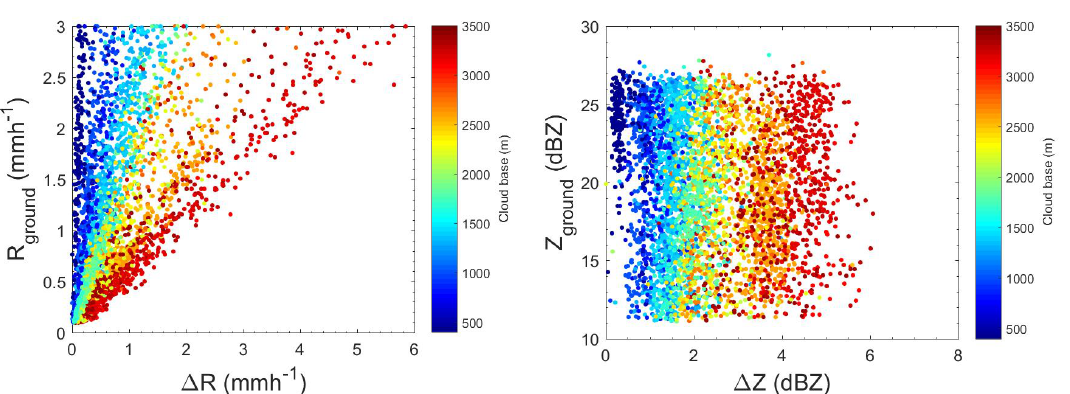
Figure 4. Trend of the difference between the cloud base and the ground of the rain parameters R and Z as a function of parameter values measured at ground and at cloud base